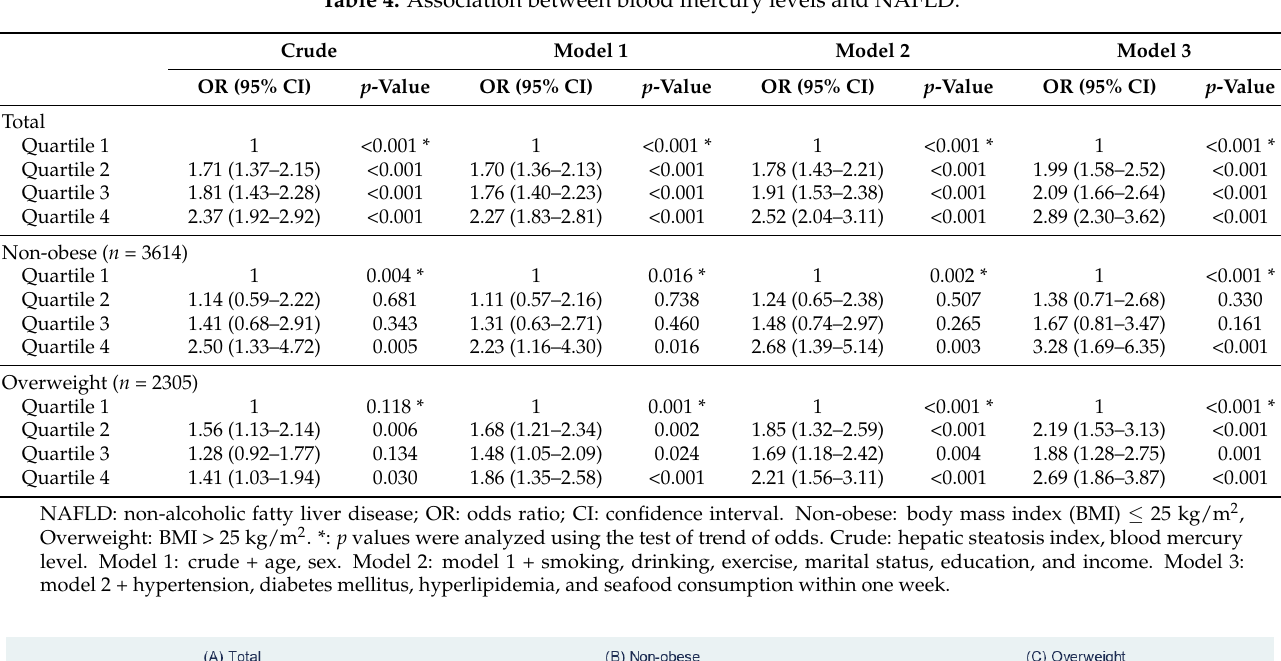
Table 4. Association between blood mercury levels and NAFLD.